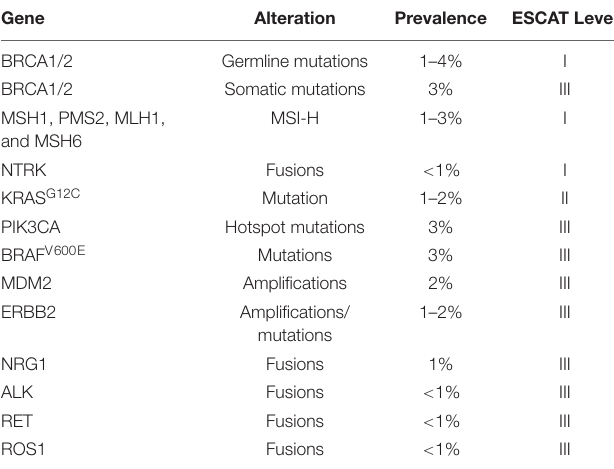
TABLE 1 | List of actionable single gene alterations to in advanced pancreatic ductal adenocarcinoma in accordance with ESMO Scale for Clinical Actionability of Molecular Targets (ESCAT) levels I–III (Mateo et al., 2018; Mosele et al.,